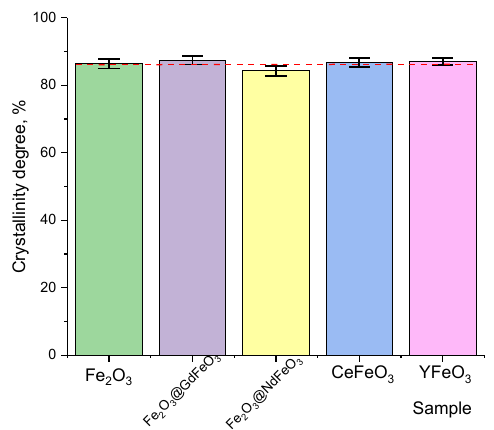
Figure 3. Assessment results of the structural ordering degree of the synthesized nanocomposites.